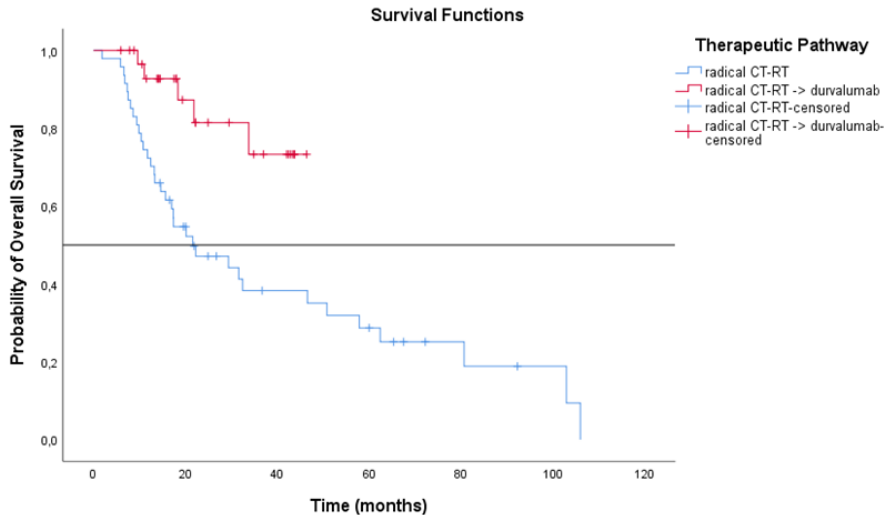
Figure 16. Kaplan–Meier curves of estimated relapse-free survival in the entire population who un- derwent definitive chemo-radiation therapy according to treatment pathway. CT-RT, chemo-radia- tion therapy.